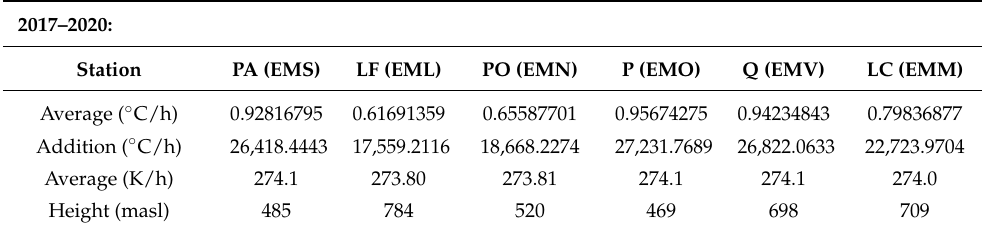
Table 4. For the period 2017–2020, in all the measurement locations, the average of and the height with respect to sea level are presented.